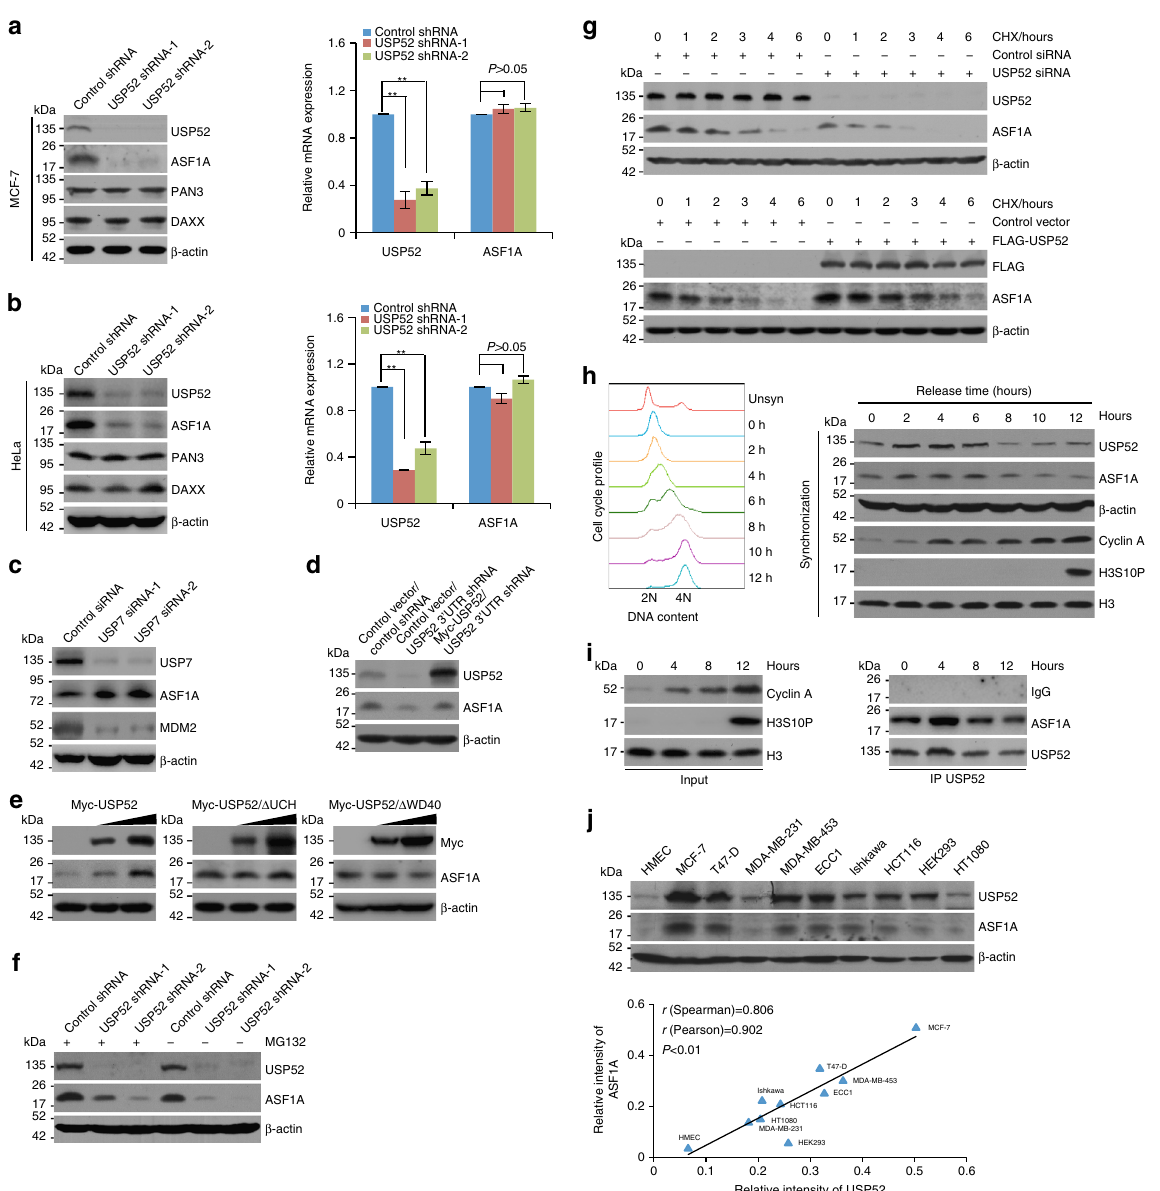
Fig. 4 USP52 promotes ASF1A stabilization. a MCF-7 cells stably expressing different sets of USP52 shRNAs were collected for western blotting and qRT- PCR analysis. Each bar represents the mean ± S.D. for biological triplicate experiments. ** P < 0.01, one-way analysis of variance (ANOVA). b Experiments analogous to a were performed in HeLa cells. Each bar represents the mean ± S.D. for biological triplicate experiments. ** P < 0.01, one-way ANOVA. c MCF-7 cells were transfected with control siRNA or USP7 siRNA. Cellular extracts were prepared and analyzed by western blotting. d MCF-7 cells stably expressing shRNA targeting 3 ′ UTR of USP52 were transfected with control vector or Myc-USP52 and cellular lysates were collected for western blotting analysis with antibodies against the indicated proteins. e MCF-7 cells were transfected with different amounts of wild-type USP52, USP52 lacking UCH domain (USP52/ Δ UCH), or USP52 lacking WD40 repeat domain (USP52/ Δ WD40), and cellular lysates were collected for western blotting analysis with antibodies against the indicated proteins. f MCF-7 cells stably expressing different sets of USP52 shRNAs were treated with proteasome inhibitor MG132 (10 μ M) or DMSO. Cellular extracts were prepared and analyzed by western blotting. g MCF-7 cells transfected with control siRNA or USP52 siRNA were treated with cycloheximide (CHX) and harvested at the indicated time followed by western blotting analysis (upper panel). MCF-7 cells stably expressing control vector or FLAG-USP52 were treated with CHX and harvested at the indicated time followed by western blotting analysis (lower panel). h HeLa cells synchronized by double-thymidine block were released and cellular extracts were collected for western blotting analysis with antibodies against the indicated proteins. Representative cell cycle pro fi les are shown. i HeLa cells synchronized by double-thymidine block were released and cellular extracts were collected for co-immunoprecipitation analysis of the association of ASF1A with USP52. j Western blotting analysis of the expression of ASF1A and USP52 in multiple cell lines. The intensity of each band was quanti fi ed by densitometry with Image J software with β -actin as a normalizer. The correlation coef fi cient and P- values are